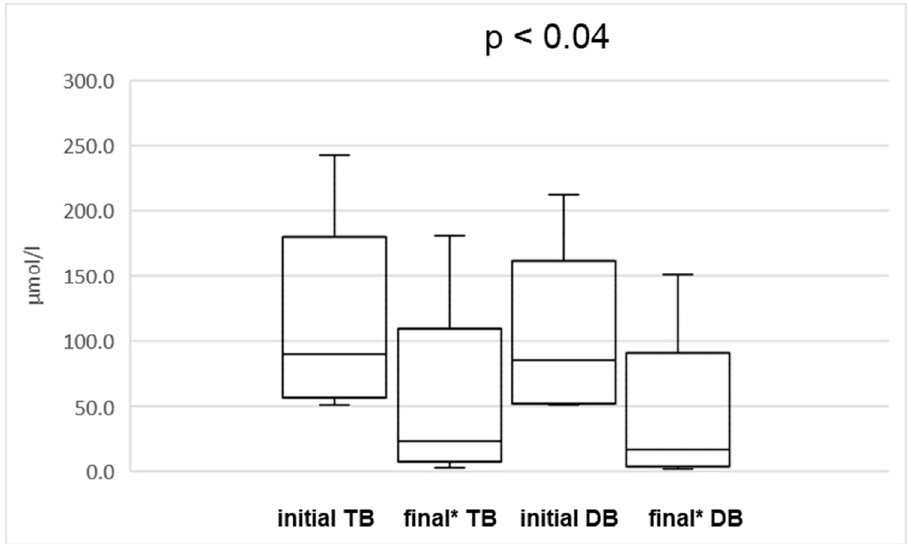
Figure 3. The comparison of initial and final (* at the end of combination therapy) total (TB) and conjugated bilirubin (CB) concentration in initially cholestatic patients. The lower and upper borders of the box indicate 25th and 75th percentiles, respectively. The line within the box depicts the median. The error bars indicate minimum and maximum.